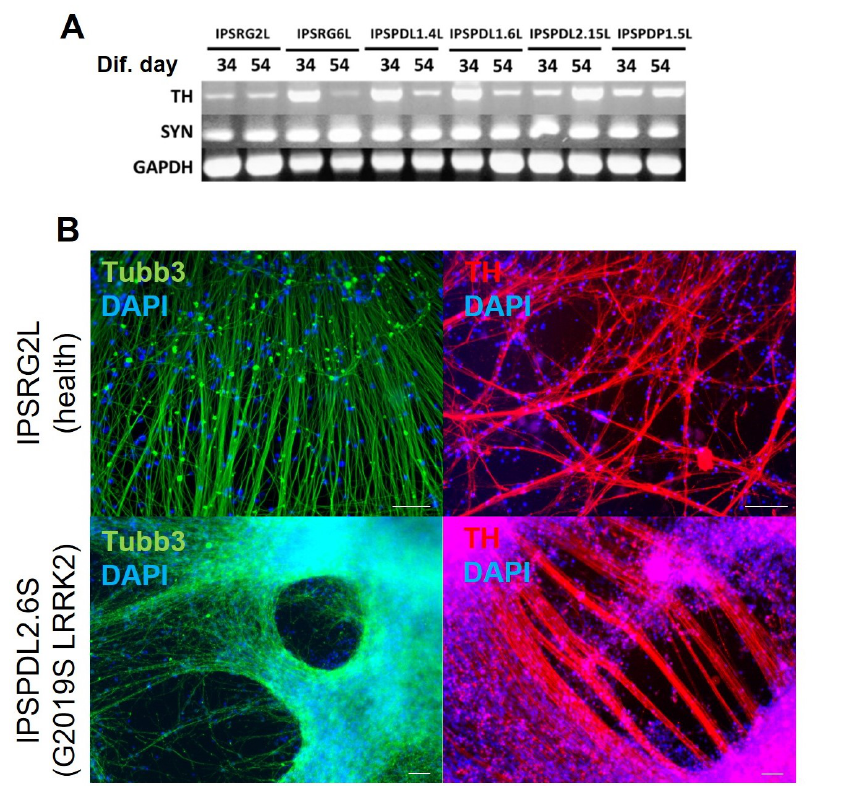
Figure 3. Analysis of neuronal cultures after 34 days of differentiation for expression of neuronal markers and a marker of the mature state of neurons by PCR and immunocytochemistry. ( A )— PCR analysis of neuronal cultures, differentiated from healthy and PD iPSC lines. Expression of common neuronal marker (SYN, synaptophysin) and DAns marker (TH) was shown at 34